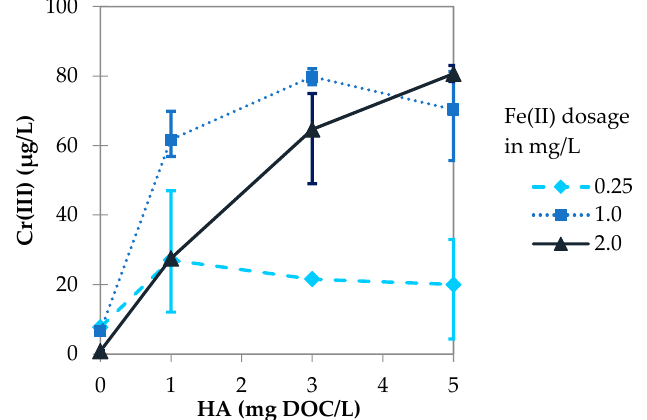
Figure 7. Cr(III) residual concentrations as a function of the presence of HAs (0, 1, 3, 5 mg DOC/L) at pH 7 and Fe(II) dosages 0.25, 1.0, and 2.0 mg/L. Mean values with vertical bars indicate the respective range. The results were obtained with both set-ups A and B.